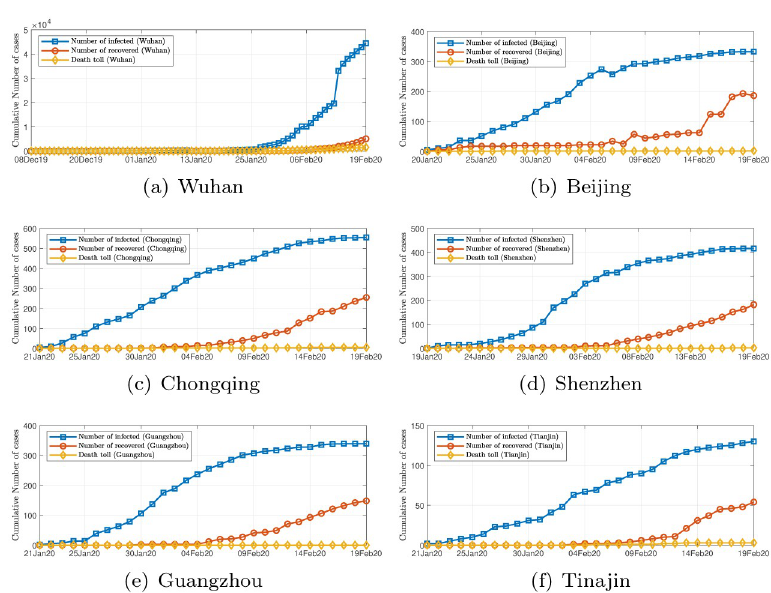
Fig 2. Daily data of COVID-19 infections in six Chinese cities from December 8, 2019 to February 13, 2020. (a) Wuhan (available from December 8, 2019); (b) Beijing (available from January 20, 2020); (c) Chongqing (available from January 20, 2020); (d) Shenzhen (available from January 19, 2020); (e) Guangzhou (available from January 21, 2020); (f) Tianjin (available from January 21, 2020).